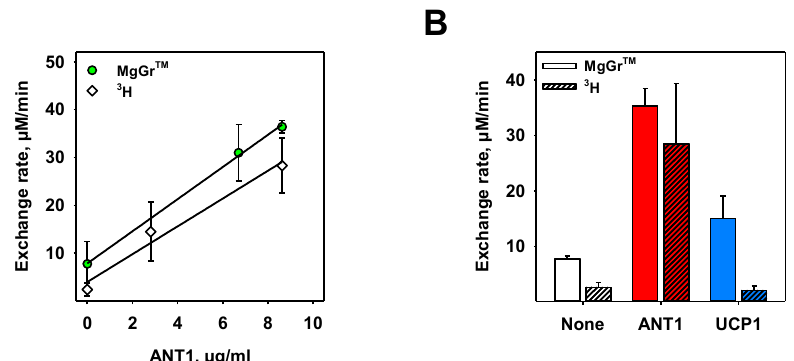
Figure 4. Determination of ANT1 specificity of ADP/ATP exchange. ( A ) ADP/ATP exchange rates at different ANT1 concentrations measured in the fluorescent (green circles) and radioactive (open diamonds) assay. Lines are a linear fit to the data. ( B ) Exchange rates measured in the absence of protein (open bars), and in the presence of ANT1 (red bars) and uncoupling protein 1 (UCP1, blue bars) in liposomes measured with Magnesium Green (MgGr) TM (left bar of each data set) and 3 H radioactivity (right bar of each data set). ANT1 and UCP1 were used at 8.67 µg/mL and 7.07 µg/mL, respectively. In all measurements, the buffer contained 50 mM Na 2 SO 4 , 10 mM Tris, 10 mM MES and 0.6 mM EGTA at pH = 7.34 and T = 297 K. Lipid membranes were made of 45:45:10 mol% of DOPC, DOPE and CL, respectively. The lipid concentration was 1.0 mg/mL and the liposome diameter was approximately 100 nm. Concentrations of ATP, ADP, Mg 2+ and MgGr TM were 2 mM, 2 mM, 1 mM and 3 µM, respectively. Data are shown as the mean ± SD of at least three independent measurements.